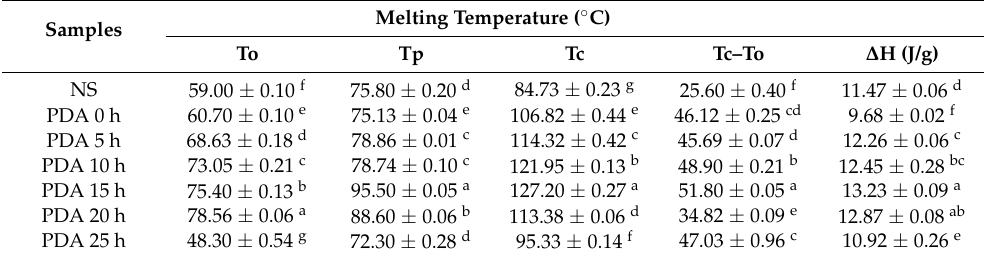
Table 4. Thermal properties of native and debranched time combined with autoclaved